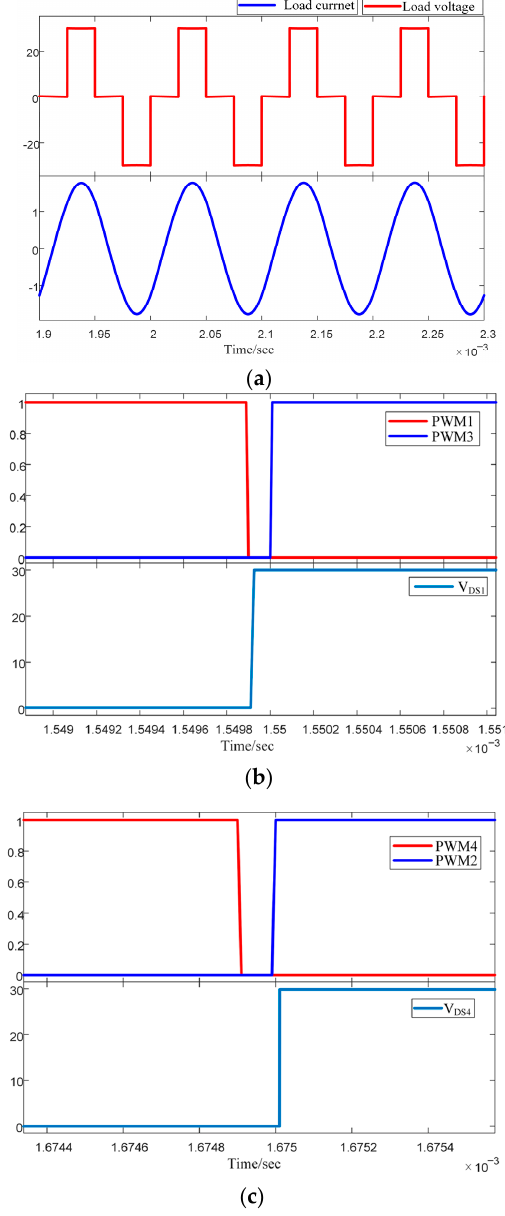
Figure 7. Main waveforms without auxiliary current source. ( a ) Load voltage and current waveform; ( b ) Q 1 Q 3 trigger signal and Q 1 drain-source voltage waveform; ( c ) Q 2 Q 4 trigger signal and Q 4 drain-source voltage waveform.